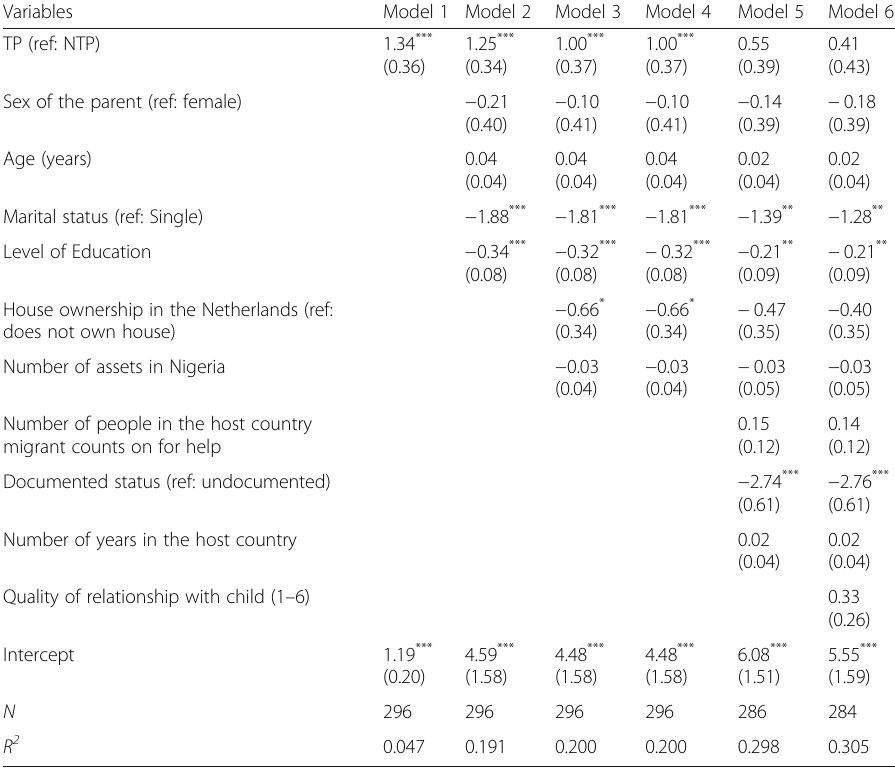
Table 8 Ordinary Least Squares regressions predicting emotional well-being, The Netherlands